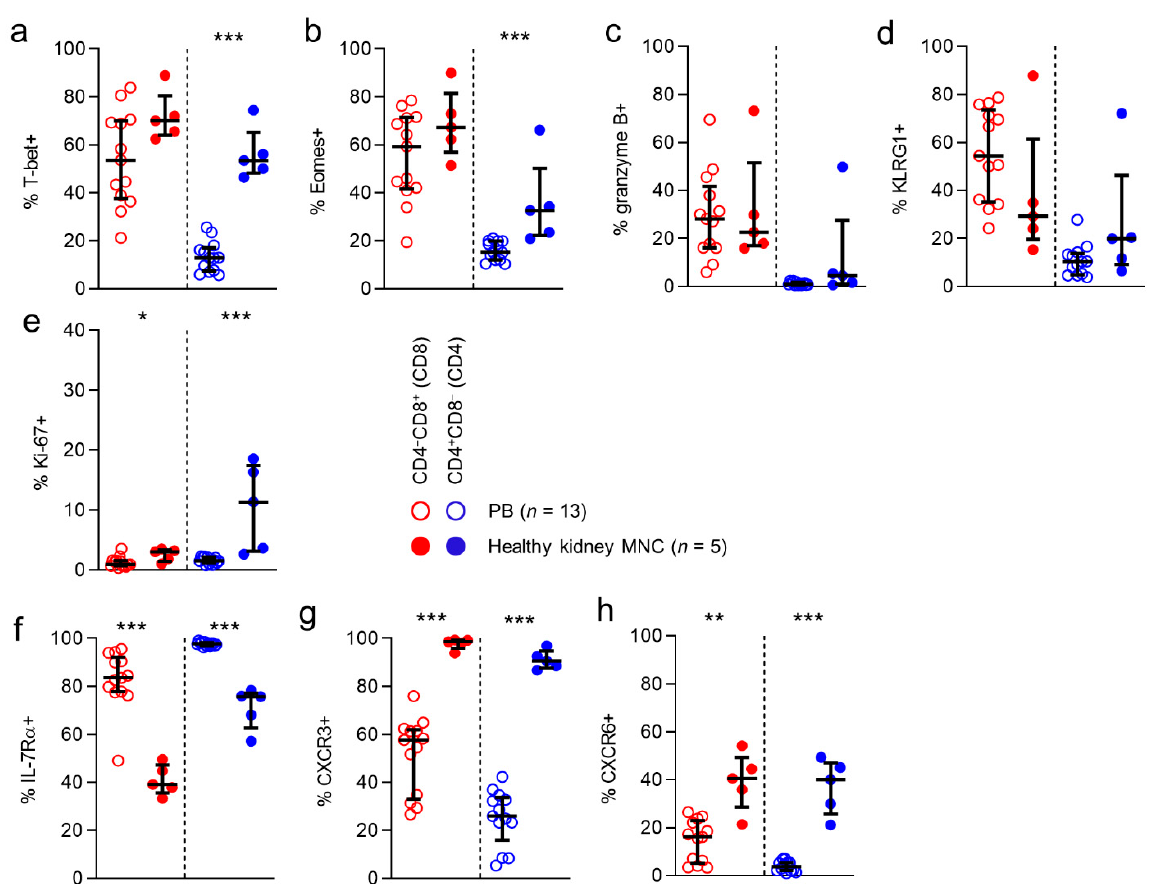
Figure 2. CD8 and CD4 T cells in kidney tissue are nearly all CXCR3-positive.( a – h ) Comparison of expression of T-bet ( a ), Eomes ( b ), granzyme B ( c ) KLRG1 ( d ), ki-67 ( e ), IL-7R α ( f ), CXCR3 ( g ) and CXCR6 ( h ) in CD8 (red) and CD4 (blue) T cells derived from peripheral blood (PB) and healthy kidney. (median with IQR in black). Mann-Whitney U-test was used for statistical comparison. Only significant p-values are displayed: * p < 0.05, ** p ≤ 0.01, *** p ≤ 0.001.